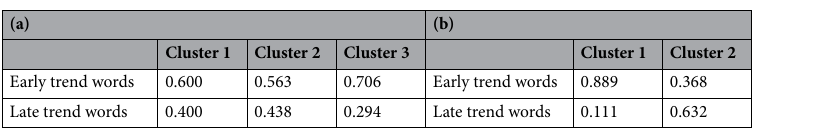
Table 3. Rates of early trend words and late trend words, as defined by Google Trends, within the clusters. (a) Results for IPCA. (b) Results for